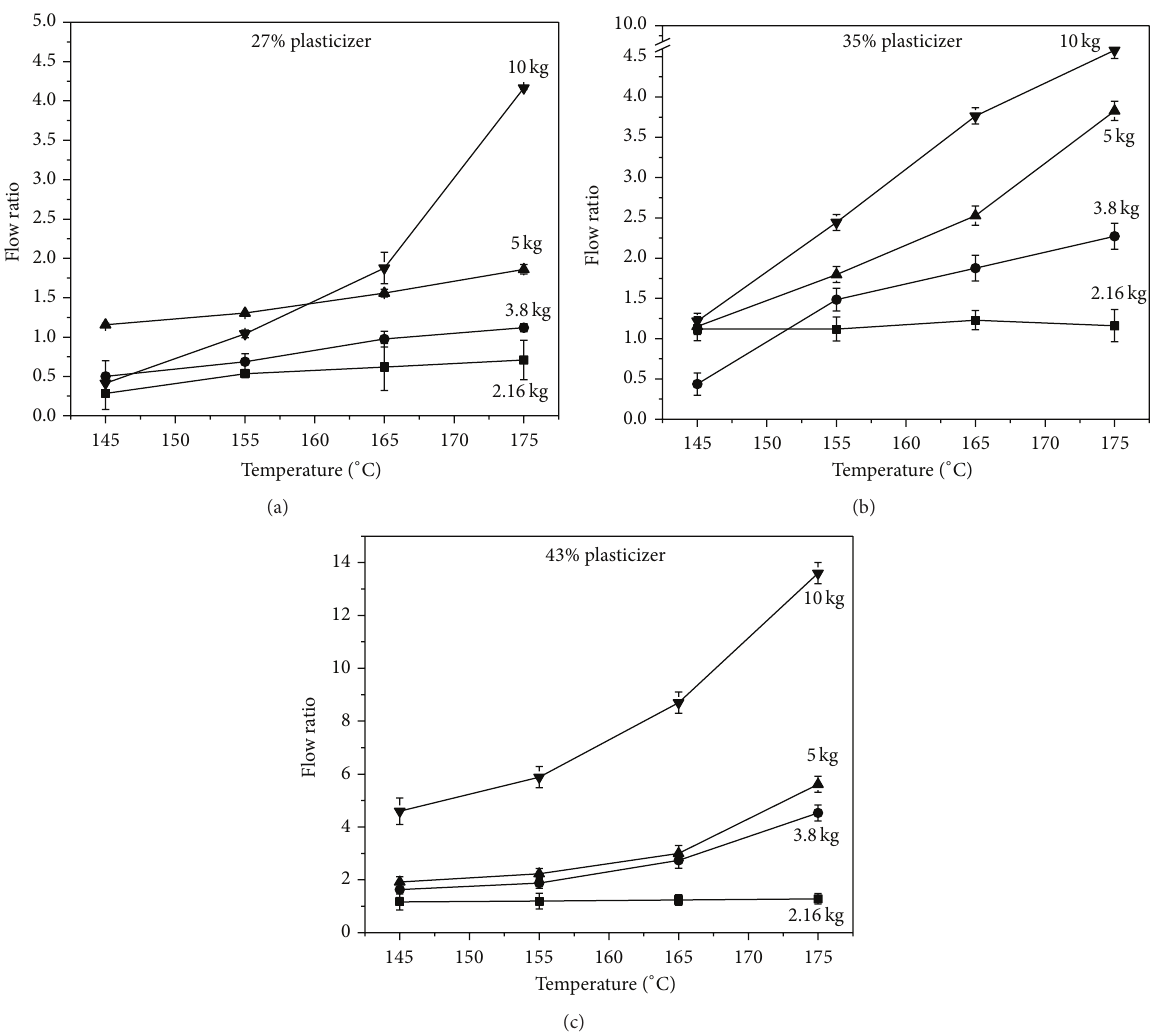
Figure 4: The dependence of flow ratio on the extrusion conditions and the plasticizing level ((a) 27%; (b) 35%; (c) 43%).